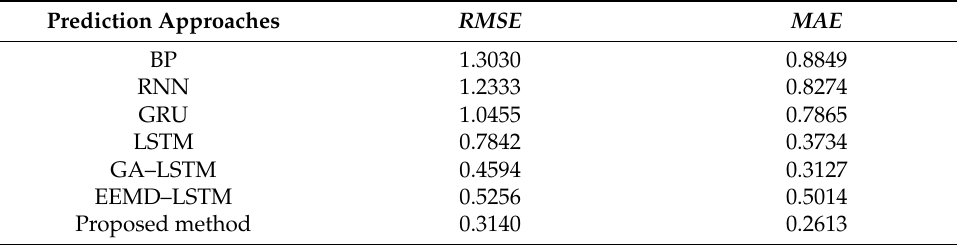
Figure 8. Comparison result of prediction performance of all prediction approaches (surface duct). Table 3. Evaluation results of predictive capacity (surface duct).